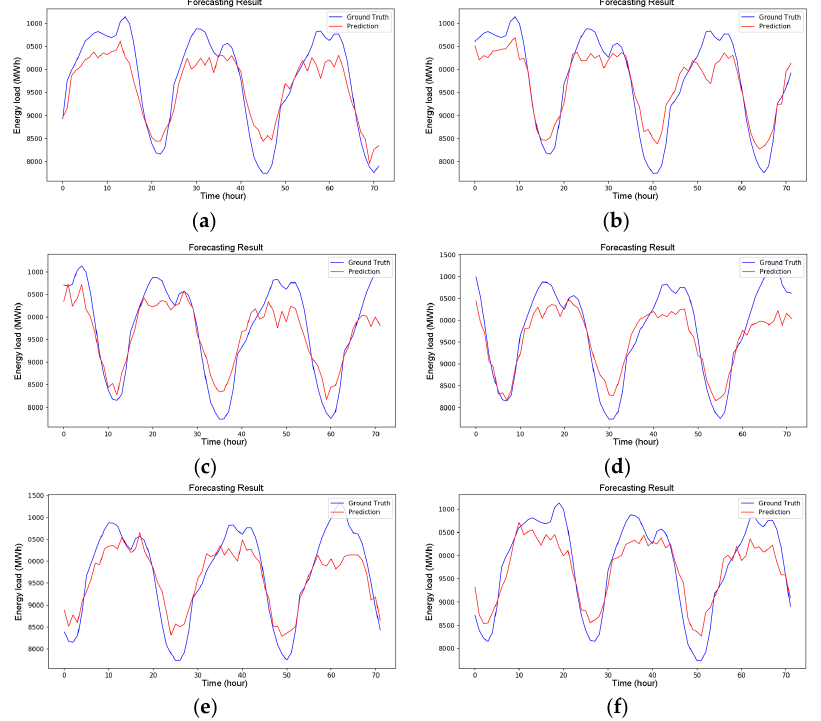
Figure 11. The forecasting results of proposed DeepEnergy: ( a ) Partial results A; ( b ) Partial results B; ( c ) Partial results C; ( d ) Partial results D; ( e ) Partial results E; ( f ) Partial results F.